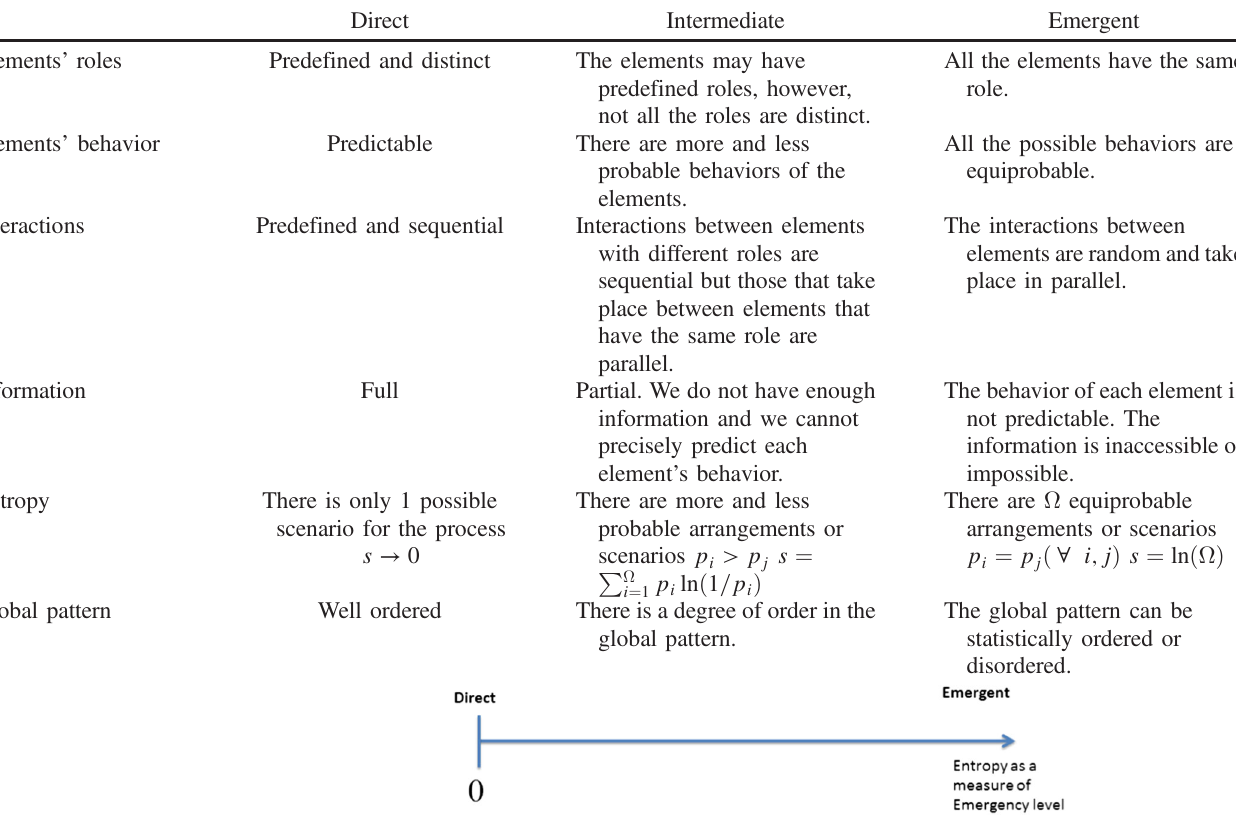
TABLE I. Main guidelines for establishing the level of emergency of